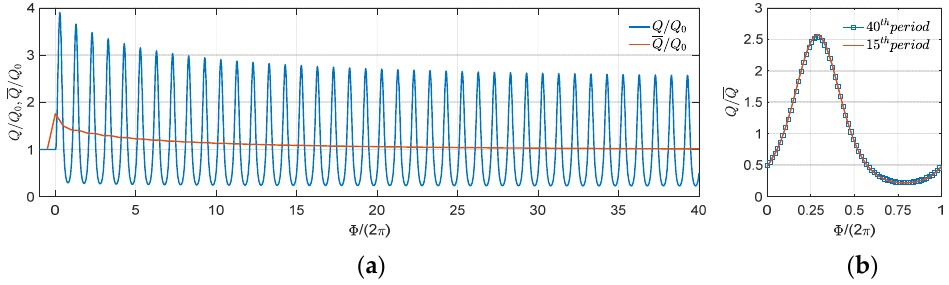
Figure A2. Adjustment to periodical currents (11) for ( a ) whitecap coverage Q and its mean-over-period value Q and ( b ) their ratio R = Q / Q showed for 40th and 15th periods. Calculations were performed for mean data characteristics ε = 0.057, U = 14.8 m/s, α = 0.63 and model parameters n = 5 and ν = .